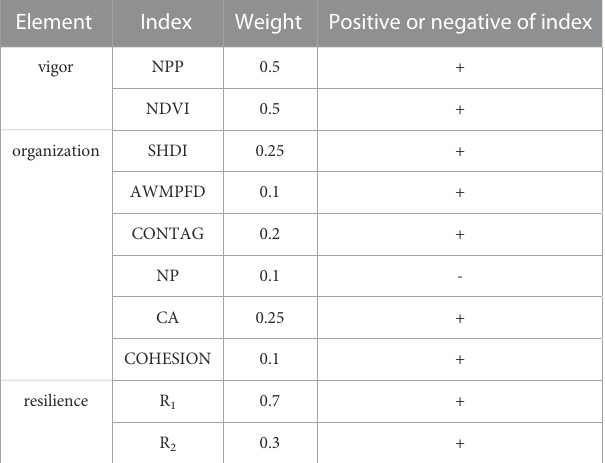
TABLE 2 Assessment index and weight of the natural health of ecosystems.